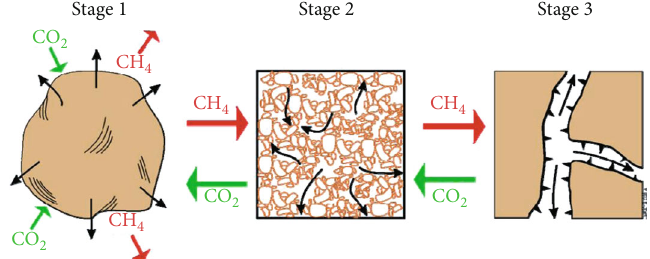
Figure 4: Schematic diagram of the competitive adsorption and transport of CO